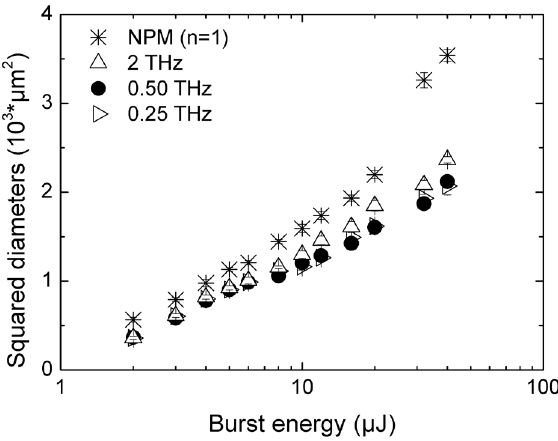
Figure 4. Squared diameters of the ablated craters performed on Si [100] samples versus burst energy, for bursts with 2 sub-pulses at three different intra-burst repetition rates. Results obtained in case of NPM are reported for comparison and indicated by the asterisk.